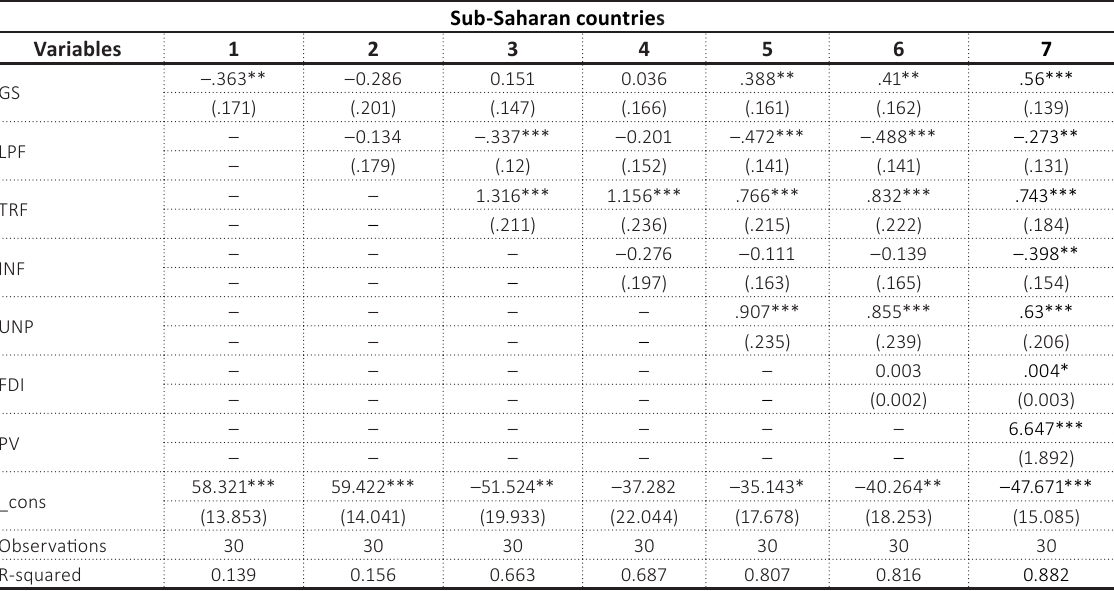
Table 5. OLS results of Sub-Saharan countries